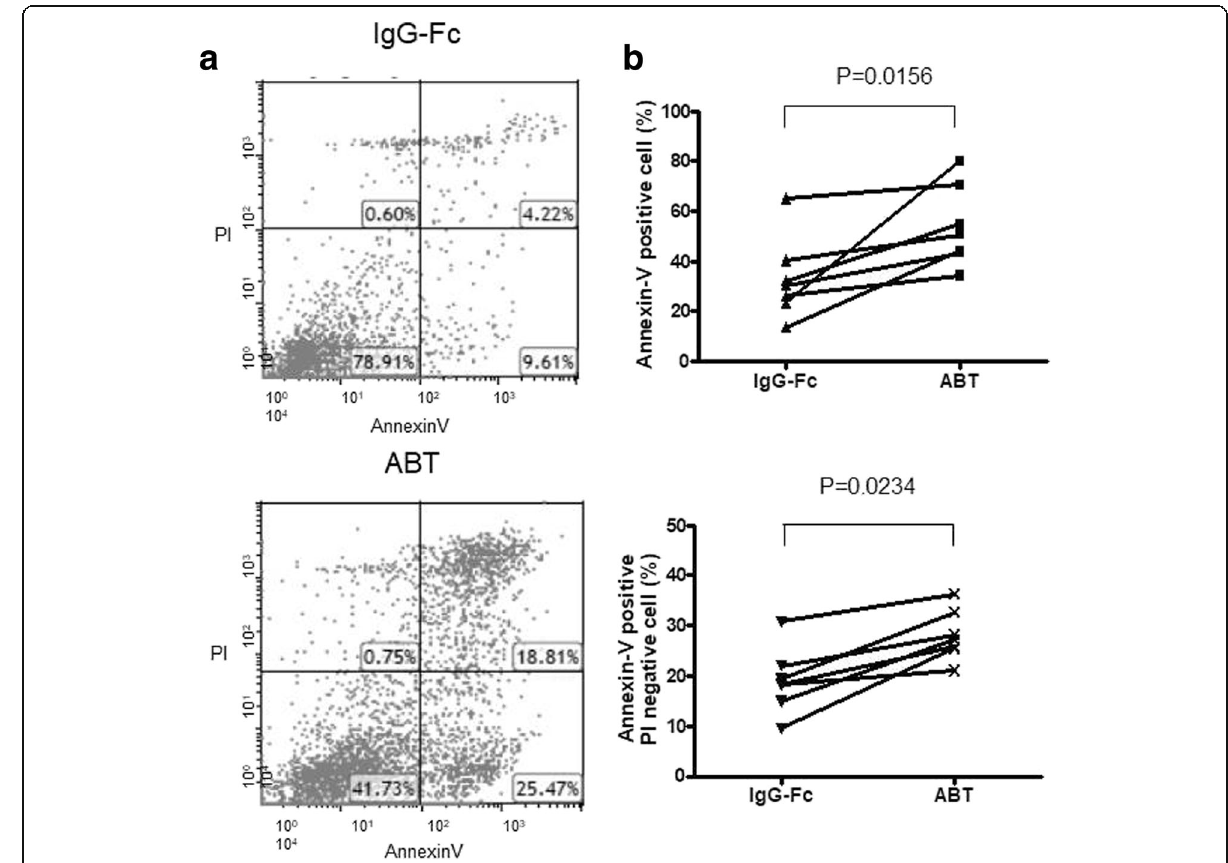
Fig. 1 Effects of abatacept on annexin V expression of SEB-stimulated monocytes. Highly purified monocytes (1 × 10 6 /well) from eight healthy individuals were cultured in the presence of SEB (100 pg/ml) in each well of 24-well flat-bottomed microtiter plates with abatacept (100 μ g/ml) or control IgG-Fc (100 μ g/ml) for 48 h, after which the cells were stained with FITC-conjugated annexin V and propidium iodide (PI). The cells were then analyzed by flow cytometry. a Representative dot plots for staining with FITC-conjugated annexin V and PI. b Percentages of total annexin V-positive cells (upper) or PI-negative annexin V-positive cells (lower) are shown. Statistical significance was evaluated by Wilcoxon ’